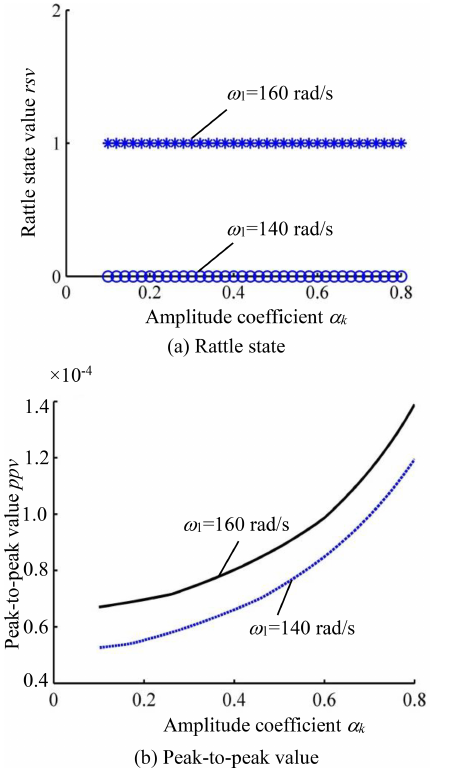
Figure 15. Change in vibration with load